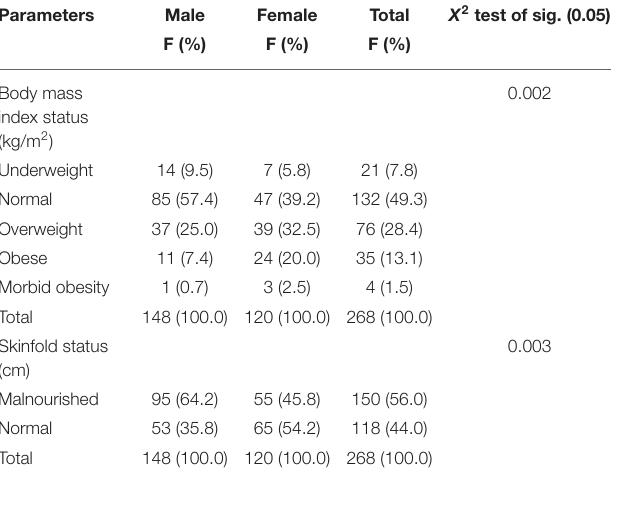
TABLE 4 | Influence of socioeconomic characteristics on nutritional status of people living with HIV/AIDS. Variable s